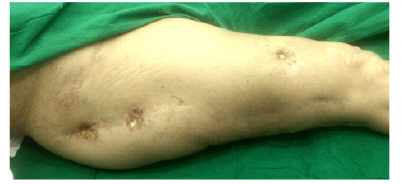
Figure 11. Multiple discharging sinuses right